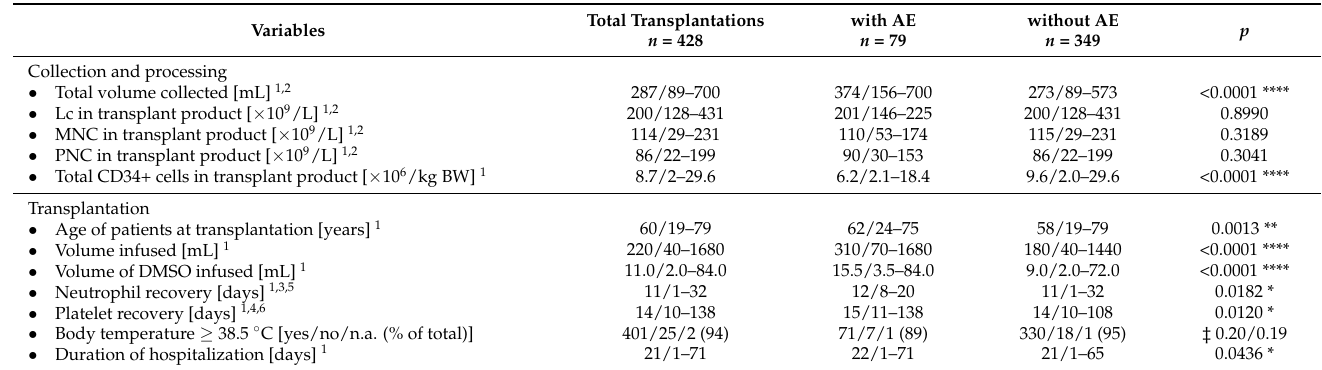
Table 3. Collection, processing and transplantation characteristics. Data without the CD34+-selected transplants.